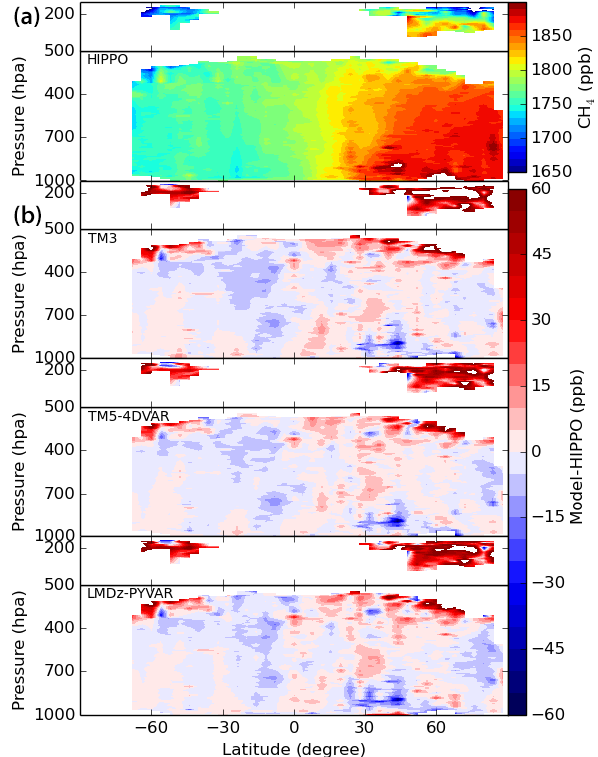
Figure 5. HIPPO-measured CH 4 and differences with models in the stratosphere (a) and troposphere (b) . The result is an average for five HIPPO missions, averaged for latitudinal bins of 4 ◦ and vertical increments of